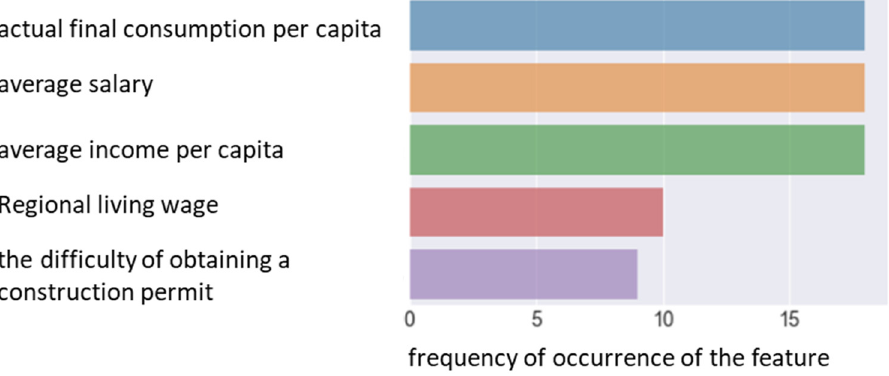
Figure 2. TOP 5 most common factors in the Central Federal District.